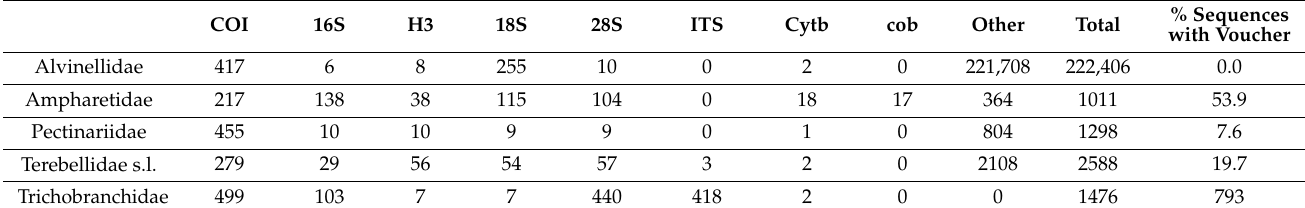
Table 3. Sequences available in Genbank for each main group of